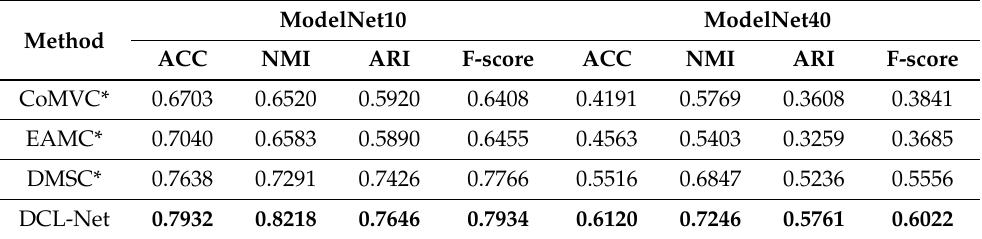
Table 1. The comparison of results from different clustering methods on the ModelNet10 and ModelNet40 datasets.